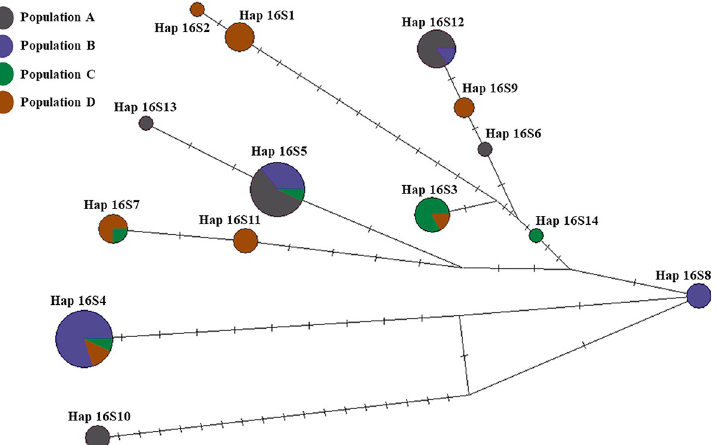
Fig 4. Mitochondrial DNA genealogy for 65 16S rRNA sequences (58 sequences from Thailand and 7 sequences from Malaysia) from C . siamensis , constructed using a median joining network method. Each haplotype is represented by a circle. Sizes of the circles are relative to the number of individuals sharing specific haplotypes. Each mutation between the haplotypes is represented by a bar.